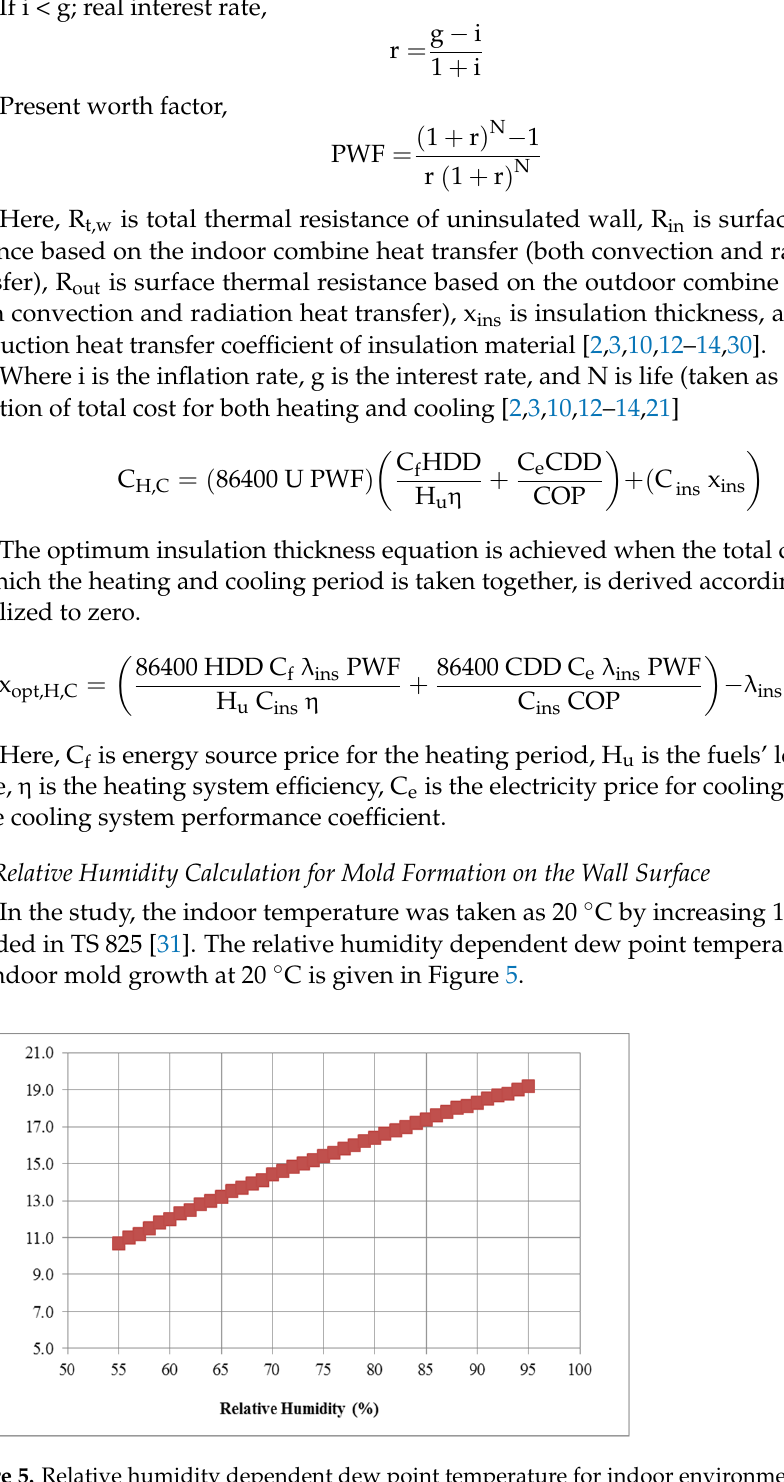
Figure 5. Relative humidity dependent dew point temperature for indoor environment. For the cities selected in the calculations of the indoor relative humidity required for the formation of mold on the surface, the month of January, when the outdoor temperature is minimum, has been accepted.